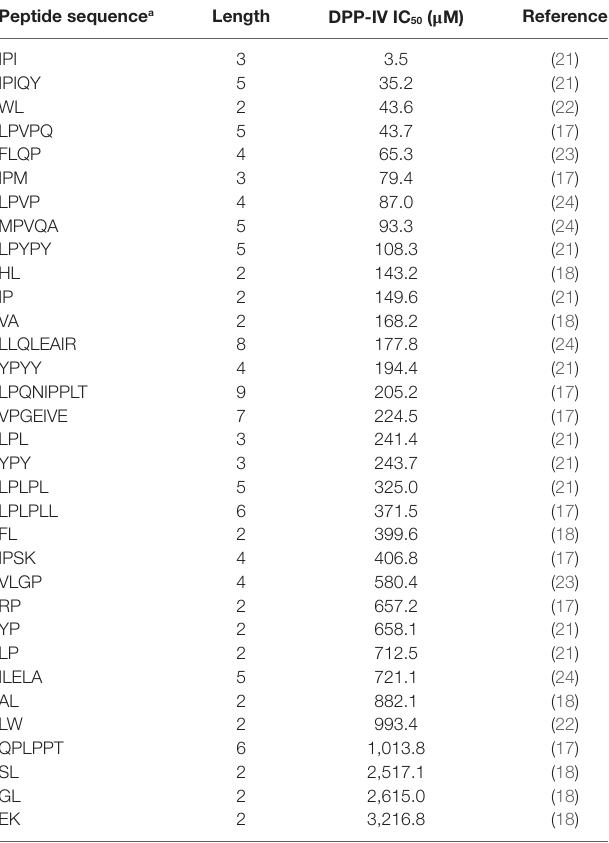
Table 1 | Dipeptidyl peptidase IV (DPP-IV) half maximal inhibitory concentration (IC 50 ) of competitive inhibitory peptides used in the quantitative structure activity relationship model. Peptide sequence